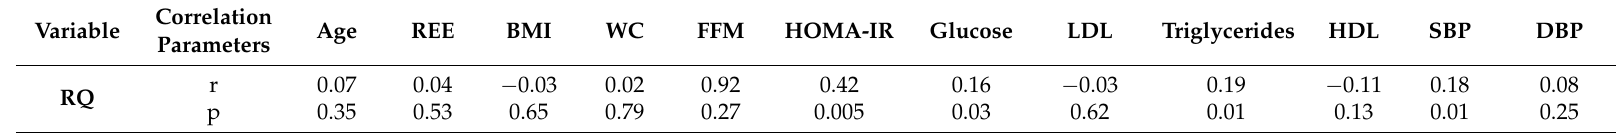
Table 3. Pearson correlation-factors correlated to respiratory quotient.